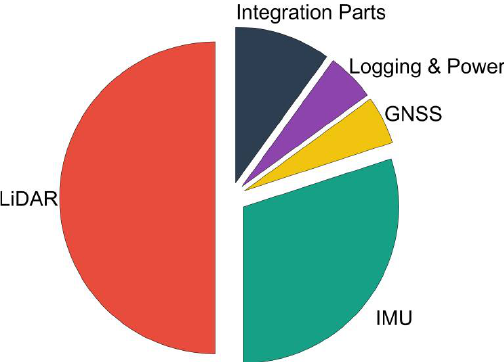
Figure 13. The relative incidence of each component in the total cost of the LasUAV hardware.